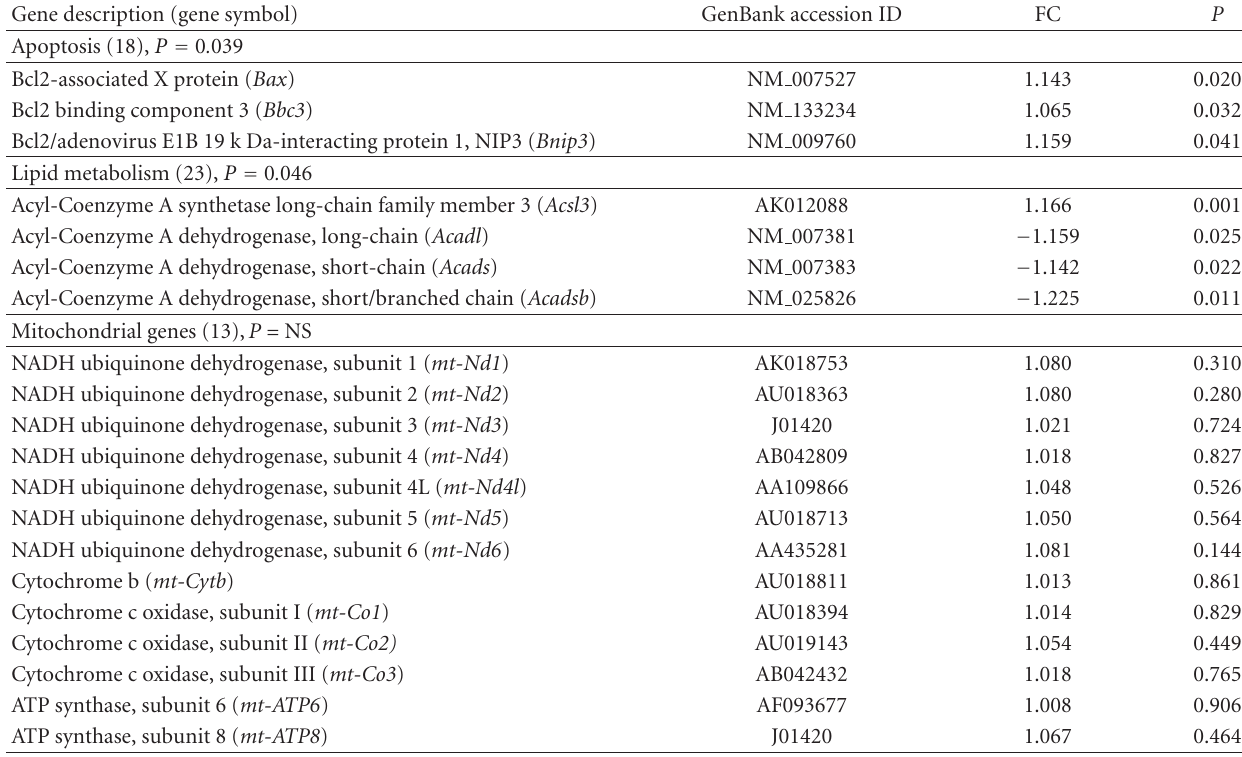
Table 3: E ff ect of AZT (600 mg/kg/d) on the expression levels of genes in the liver of B6C3F 1 mice.